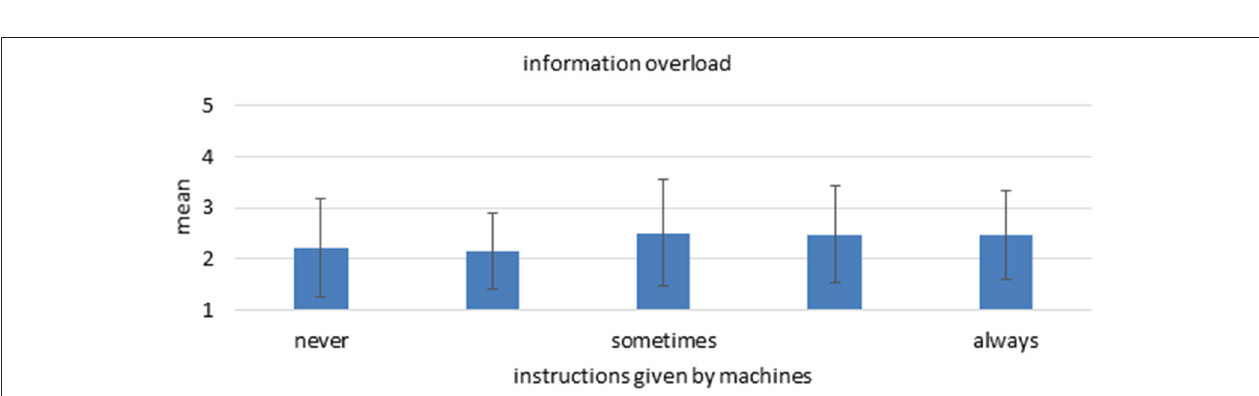
FIGURE 5 | Mean and standard deviation of the item “repetition” among the different “instructions by ICT” groups. n = 5,587, linear regression coefficient beta = 0.179, p < 0.001.